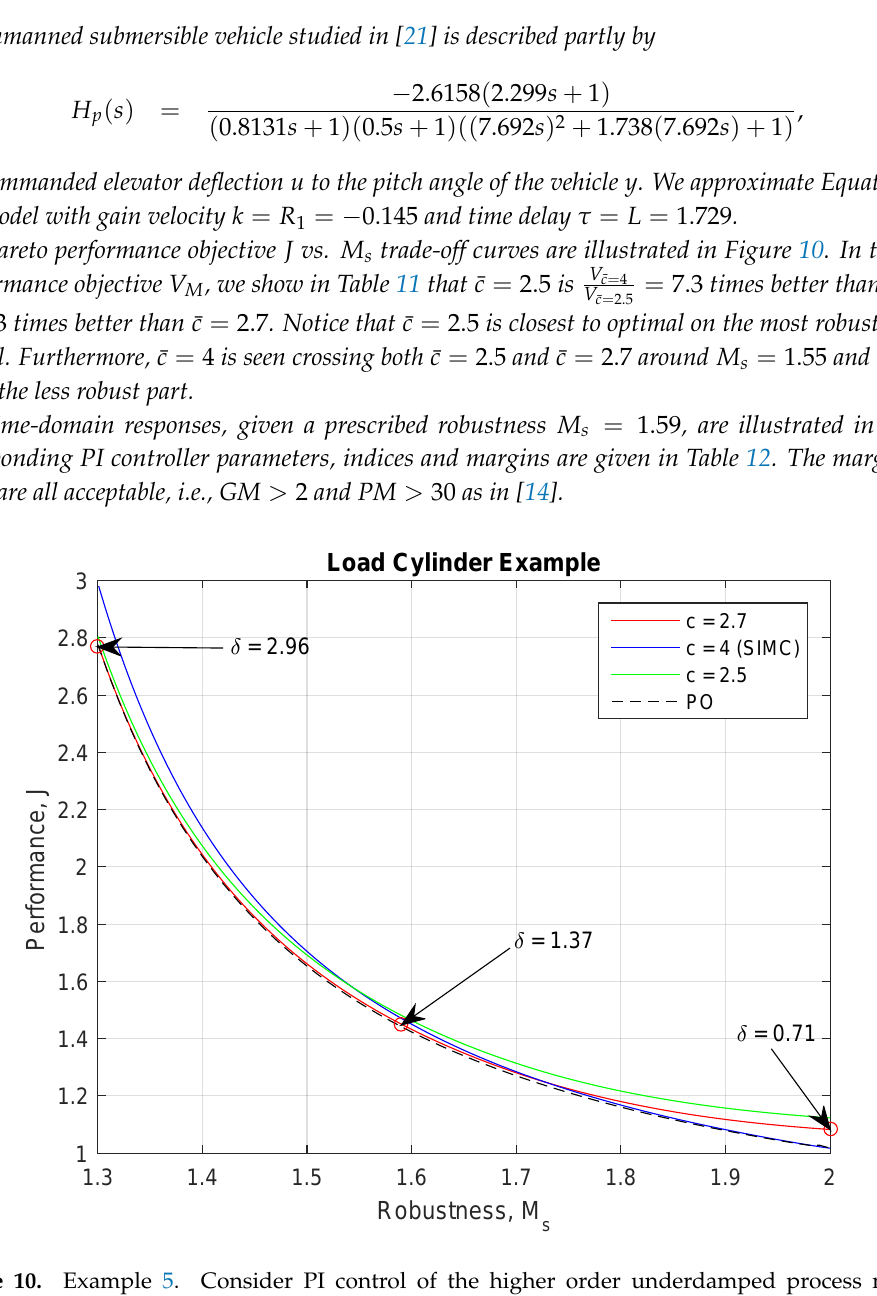
Figure 10. Example 5. Consider PI control of the higher order underdamped process model (Equation (48)). The figure shows the trade-off curves with the Pareto performance objective J (Equation (41)) and robustness M s (Equation (10)). It illustrates the PO PI controllers and PRC + Algorithm 1 variants with MP parameter settings ¯ c = 4.0, ¯ c = 2.5 and ¯ c =